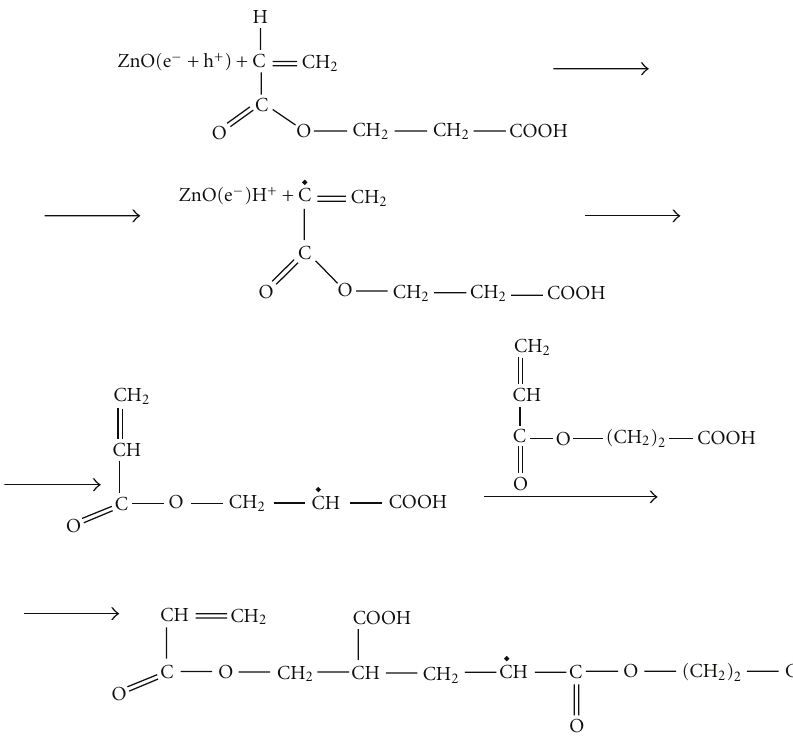
Figure 5: Scheme of photocatalysis